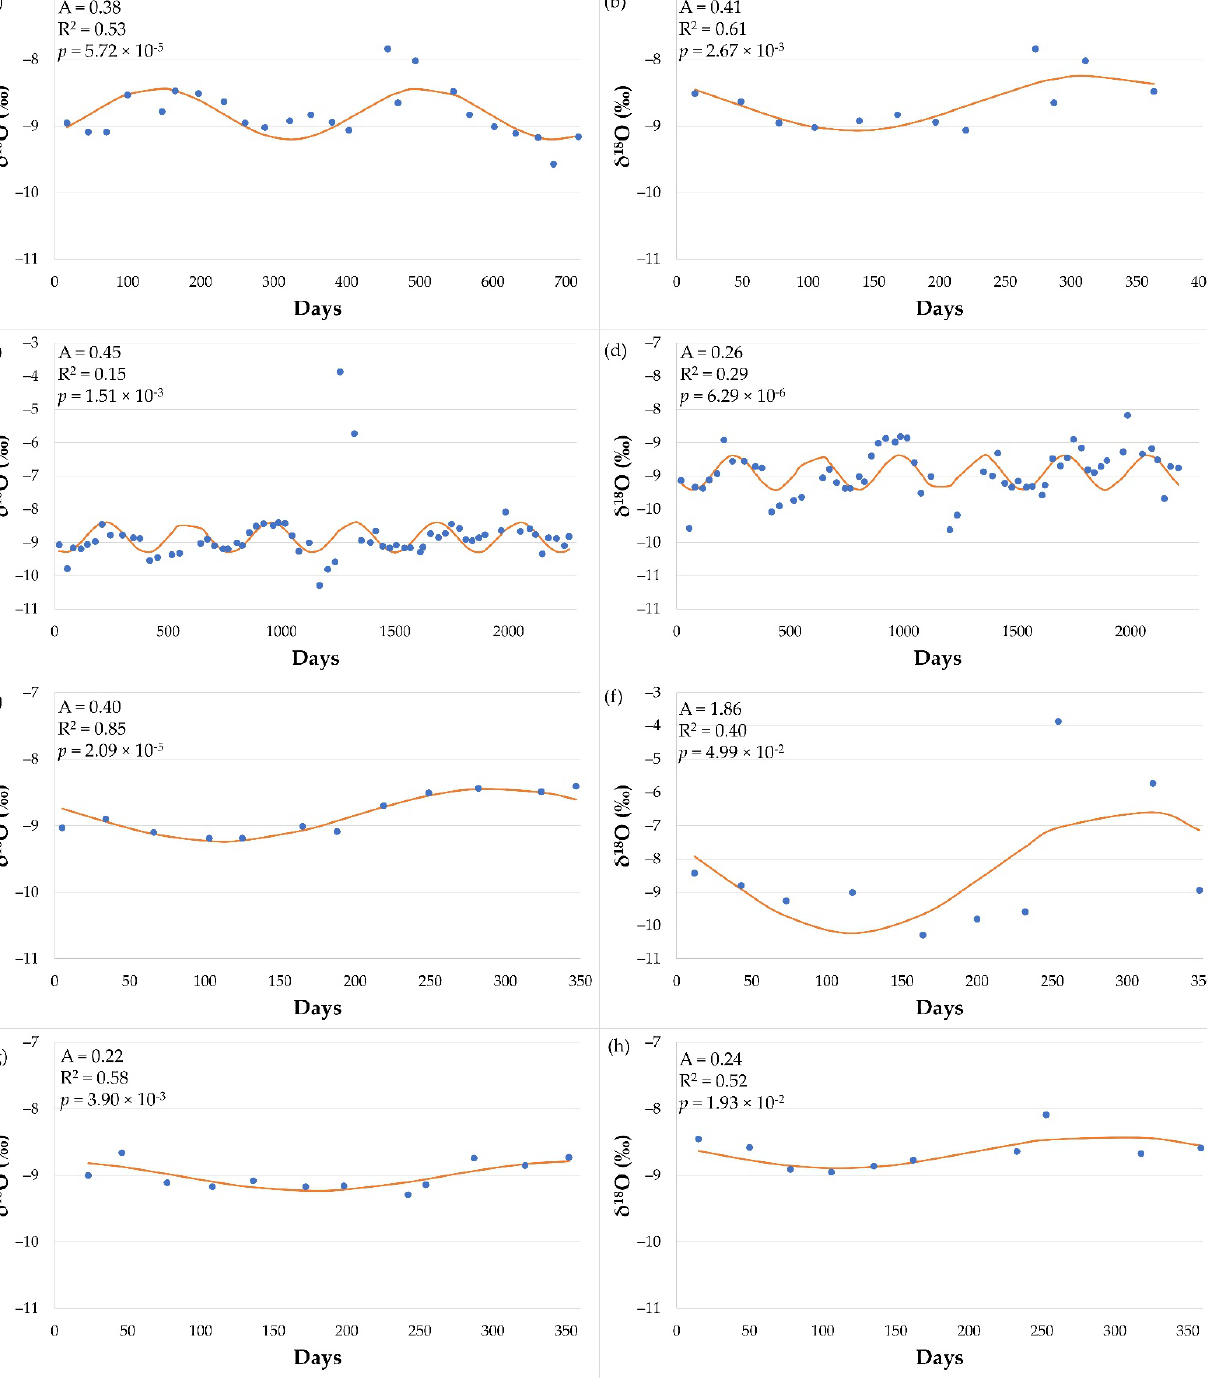
Figure 7. Fitted annual regression models to δ 18 O for the PM bridge and DM bridge. ( a ) for PM bridge based on the all available data; ( b ) for PM bridge based on the data from hydrological year 2019/2020; ( c ) for DM bridge based on the all available data taking into account outliers and extreme values; ( d ) for DM bridge based on the all available data not taking into account outliers and extreme values; ( e ) for DM bridge based on the data from hydrological year 2016/2017; ( f ) for DM bridge based on the data from hydrological year 2017/2018; ( g ) for DM bridge based on the data from hydrological year 2018/2019; ( h ) for DM bridge based on the data from hydrological year 2019/2020.